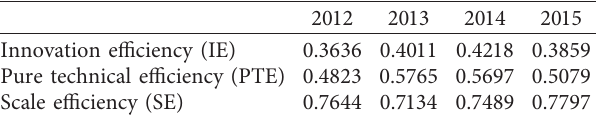
Table 3: Innovation efficiency value of high-tech SMEs